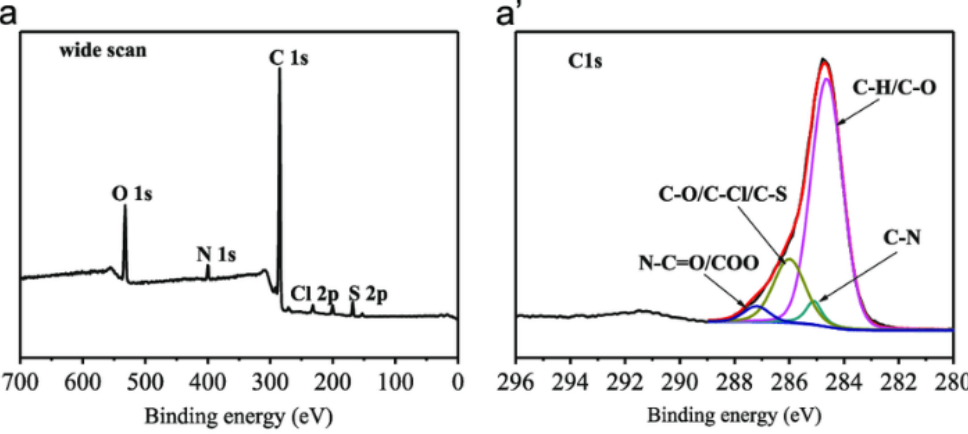
Figure 34. Components of X ‐ ray photoelectron spectroscopy (XPS) for elemental analysis [149].